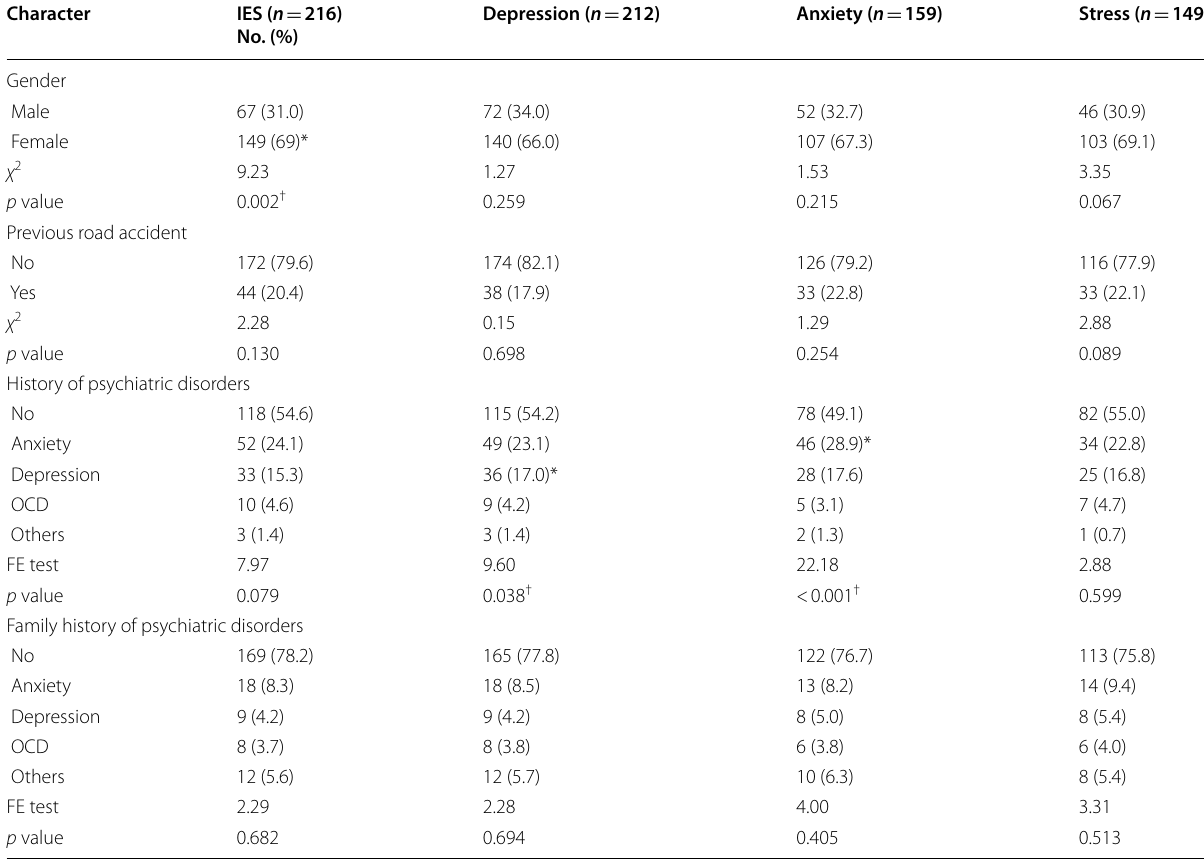
Table 4 Association between possible risk factor and different scales